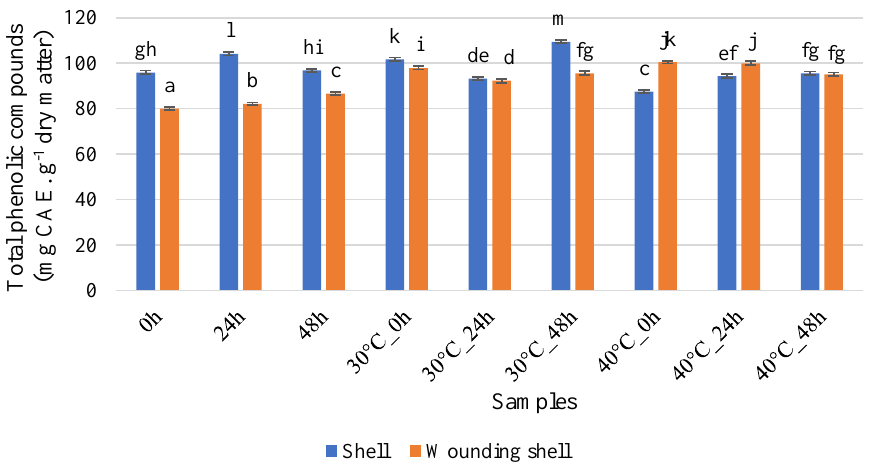
Figure 1. Effect of abiotic stresses, heat treatment and wounding, on total phenolic content of pineapple shell. Error bars stand for ± standard deviation ( n = 9). Different letters express significant differences between